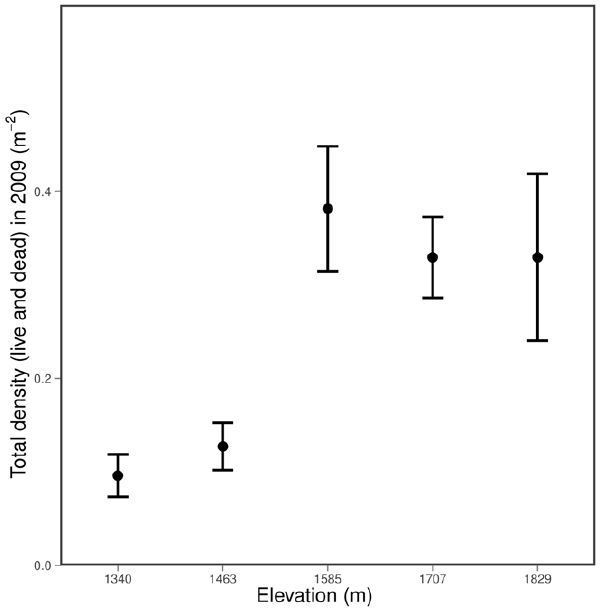
Figure 1. C.greggii density by elevation. Shown are mean densities + standard errors for 10 5 6 5 m plots per elevation.